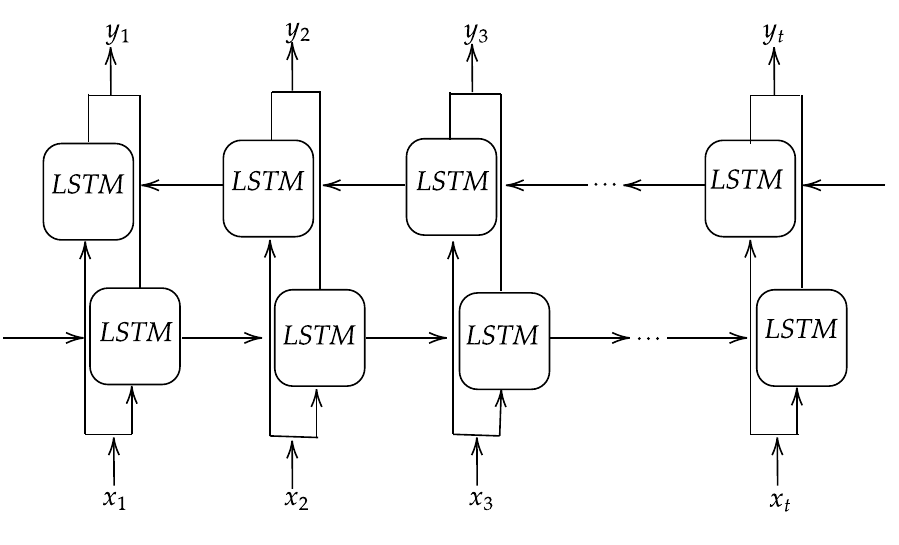
Figure 3. BLSTM layer.